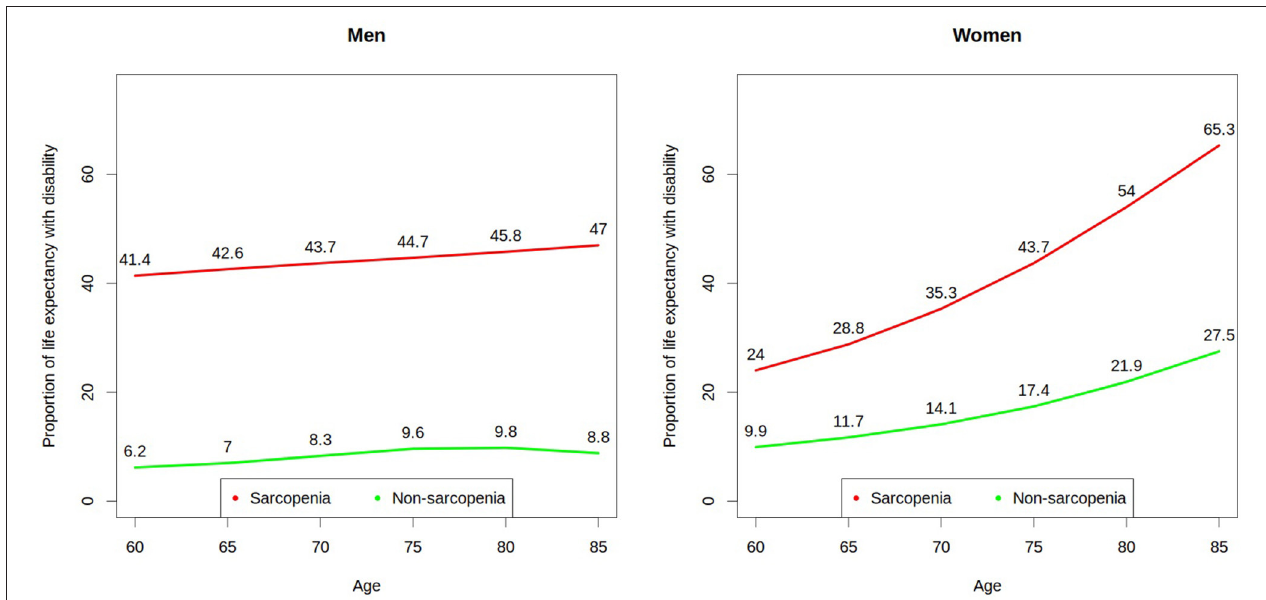
FIGURE 1 | Proportion of life expectancy to be lived with disability by Chilean older men and women with and without baseline